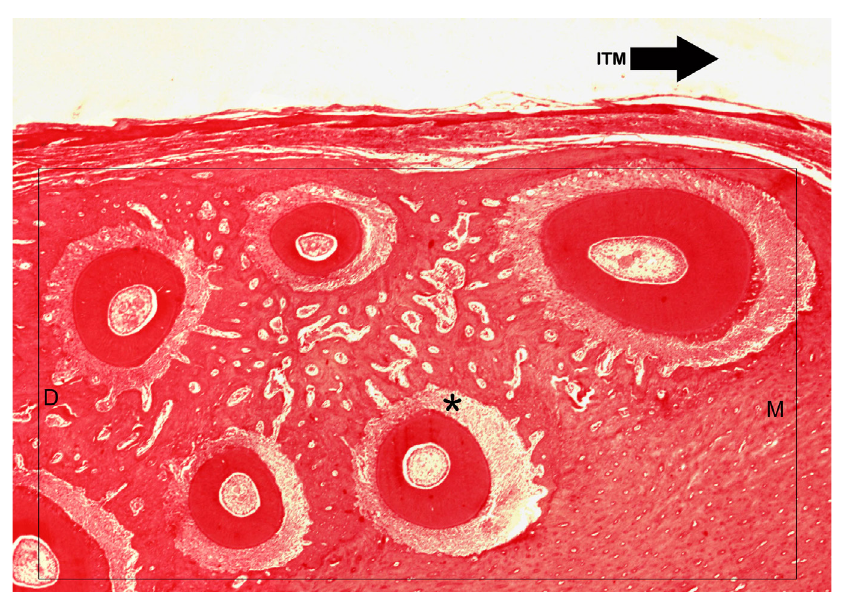
Figure 2- Distribution of experimental groups